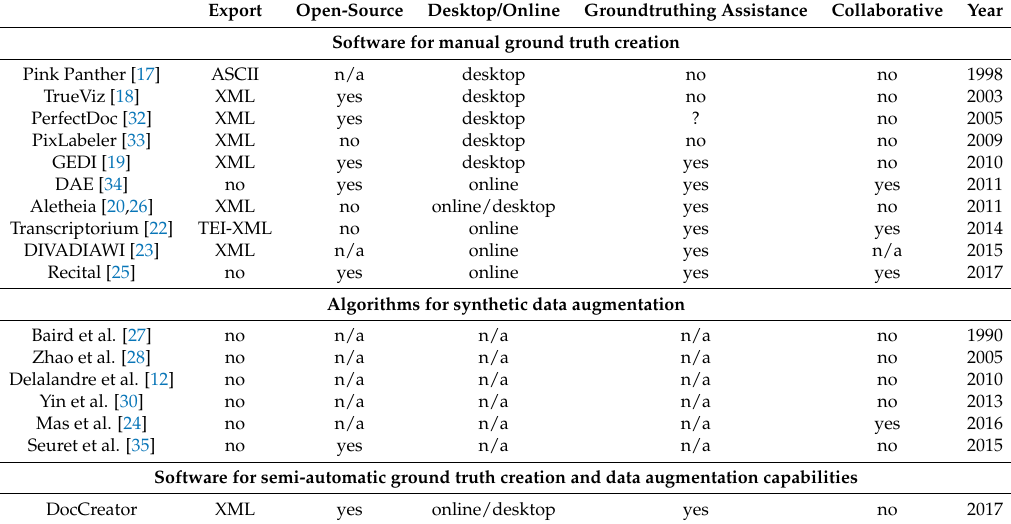
Table 1. Technical and functional characteristics of existing annotation software. Six features are presented: export format, source availability, desktop/online software, groundtruthing assistance (whether the software provides features that help the user to quickly create the groundtruth), collaborative/crowd-sourcing software, and year of